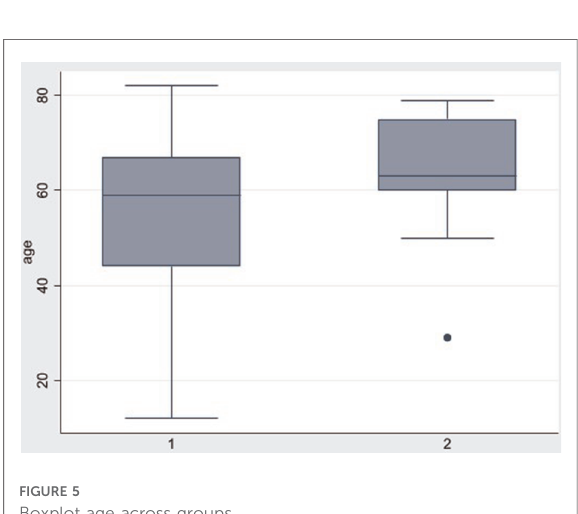
FIGURE 5 Boxplot age across